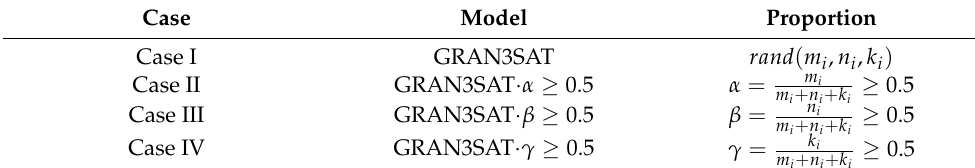
Table 6. Different cases for the GRAN3SAT